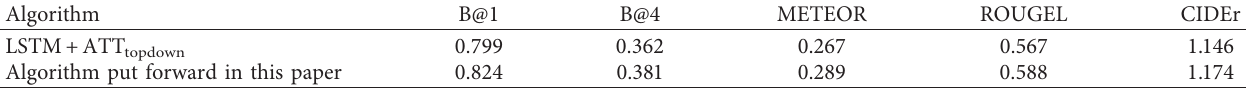
Table 1: Evaluation contrast of two generation algorithms for the multimedia image description after optimization by SCST.